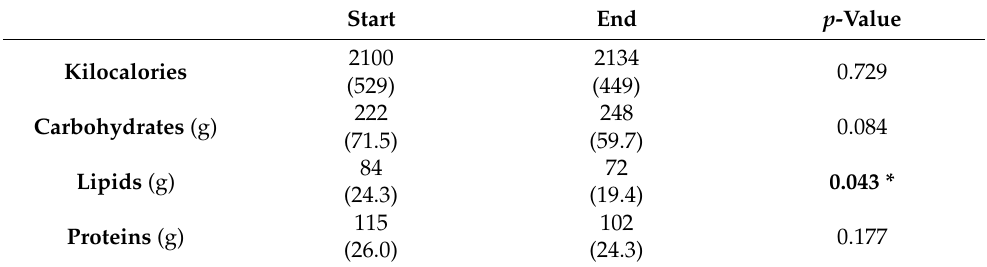
Table 2. Nutritional comparison at the start and end of the off-season period of well-trained cyclists. Start End p